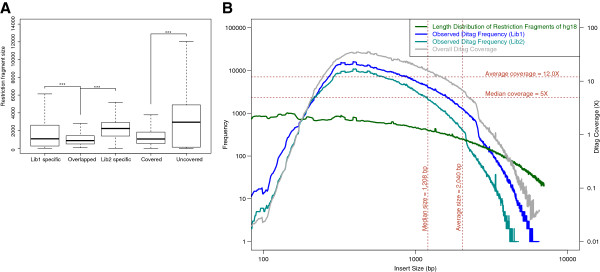
Ditag insert size analysis. A) The size distribution of restriction fragments were inferred from the ditags based on the reference sequence. The asterisks indicate the significance (p<0.001) according to a t-test. B) Distribution of ditag coverage as a function of restriction fragment size. The size distribution of restriction fragments that were generated from the hg18 reference sequence is indicated with a green line, with the vertical dashed lines indicating the average and median sizes. The observed ditag frequencies as a function of fragment size are indicated by the blue and cyan lines (one for each library). The grey line shows the average ditag coverage distribution over various fragment sizes. The horizontal dashed lines show the average and median frequency values.